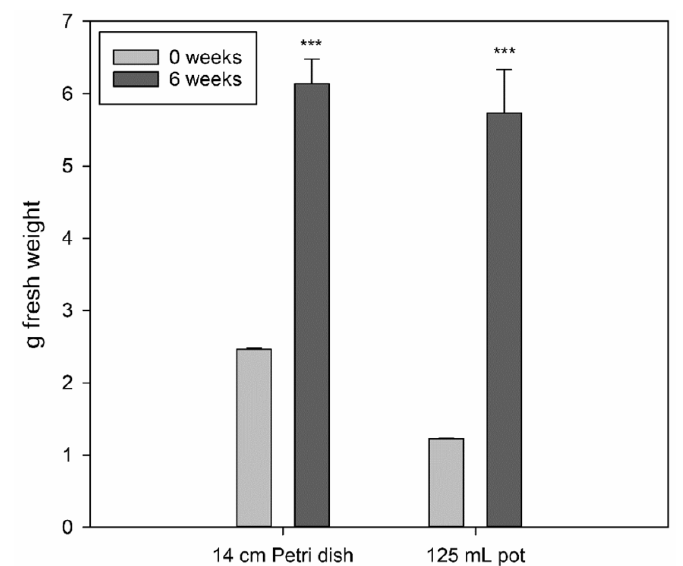
Figure 1. Yield (g fresh weight, mean ± stdev, n = 6) of the total propagated sundew tissue in six weeks on 1 MS medium on Petri dishes and 125 mL pots. A one-way ANOVA test was used to assess 2 the statistical significance of differences between 0 weeks and 6 weeks (*** = p < 0.001). No significant difference was observed between Petri dish and pot-grown biomass after 6